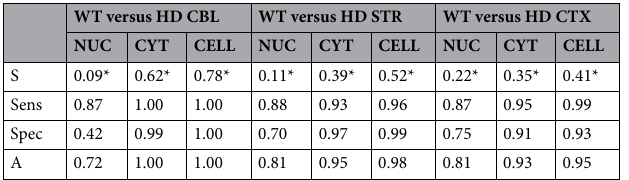
Table 1. Metrics for spectral classification (from Fig. 5). S silhouette score, Sens sensitivity, Spec specificity, A accuracy. *p value <